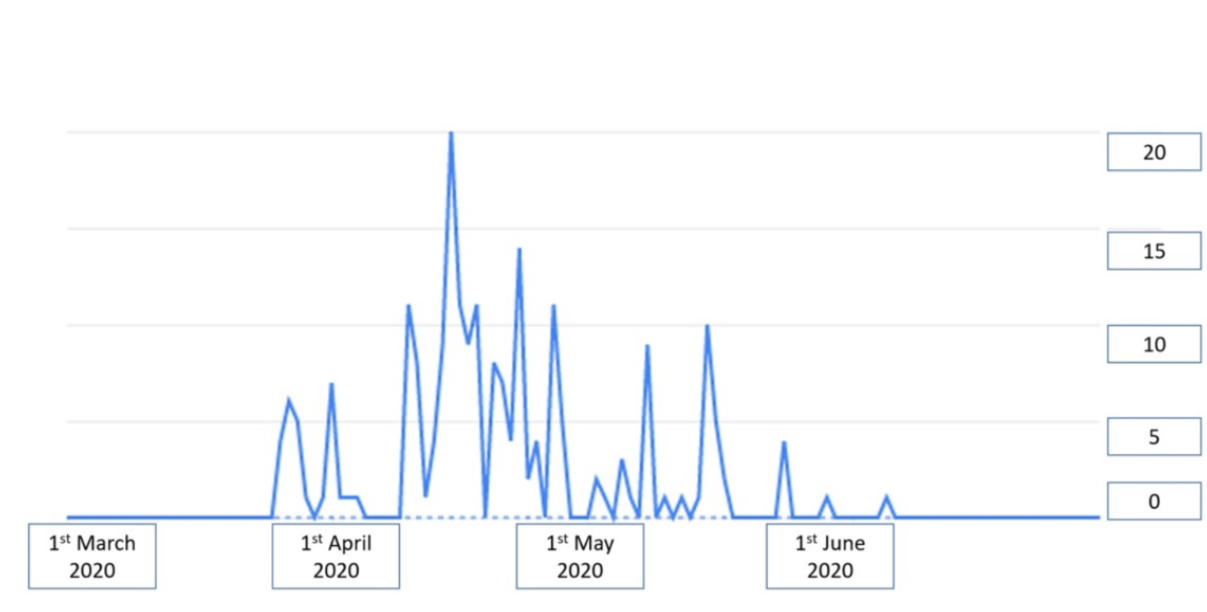
Figure 2. Timeline of the piloting and enrolment phases of the